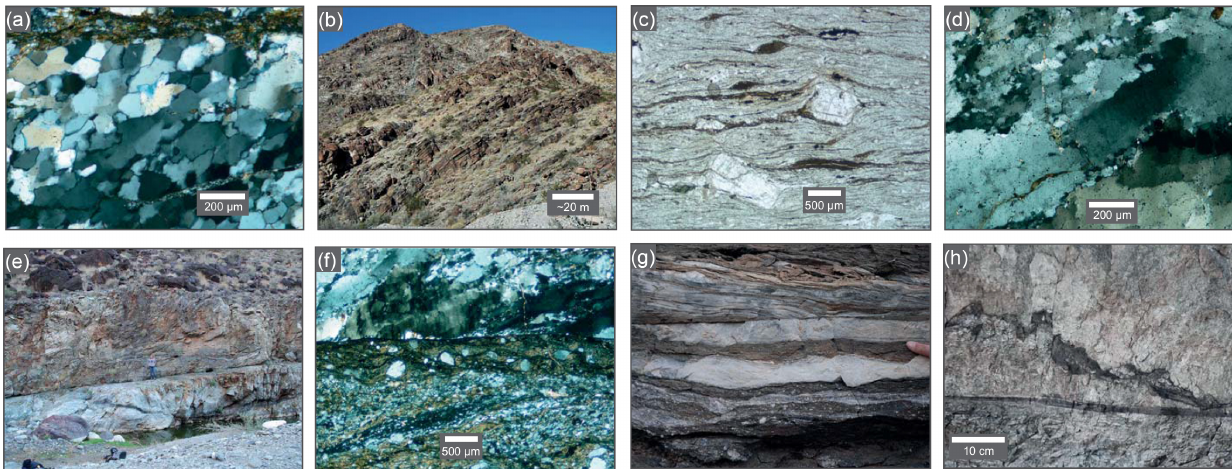
Figure 5. Field and thin section photographs from the Whipple Mountains. Locations are shown in Fig. 2a and listed in Table 1. All thin sections are oriented with NE to the right. (a) High-temperature, sub-LDT microstructure in quartz-mylonite from the west side of the range, close to the mylonitic front, and below the detachment. (b) The mylonitic front on the western side of the range, below the detachment. Fabric in mylonitic gneiss in the lower part of the hillside dips left (SW) beneath Proterozoic gneiss lacking mylonitic deformation in the upper part of the hillside. (c) Localized ductile deformation above the mylonitic front in a Chambers Wells felsic dike with a fine-grained polyphase matrix. Dynamic recrystallization has reduced quartz grain sizes to ∼ 60µm. (d) Composite microstructure in vein quartz from a mylonitic gneiss on the east side of the range, close to the detachment. Low-stress sub-LDT microstructure represented by large relict grains overprinted by a later high-stress microstructure with dynamically recrystallized grains ∼ 20µm in size. (e) Mini-detachment in Whipple Wash, lying sub-parallel to the main detachment, which is ∼ 150m above (view to SE). (f) Composite microstructure similar to (d) from below the detachment on the eastern side of the range, cut by a planar brittle shear zone with cataclastic deformation. This overprinting of different microstructures illustrates the collapsing of deformation features onto one another during the process of exhumation: high-temperature, sub-LDT distributed deformation = large relict grains; lower-temperature, localized ductile deformation = small, dynamically recrystallized grains; low-temperature brittle deformation = planar fault surface and cataclasis. (g) High-temperature, low-stress mylonite (banded gneiss and a transposed Chambers Wells dike) truncated by a detachment-parallel brittle discontinuity (view to SE). The brittle shear zone truncates the main foliation at a low angle. For structural context, see the semi-brittle slip surfaces inset in Fig. 3. This is a good illustration of how parts of the structural history can be excised during exhumation. (h) Pseudotachylite veins formed by frictionally induced melting in the immediate footwall of the Whipple detachment near Bowman’s Wash, partly disrupted by subsequent cataclastic deformation (view to